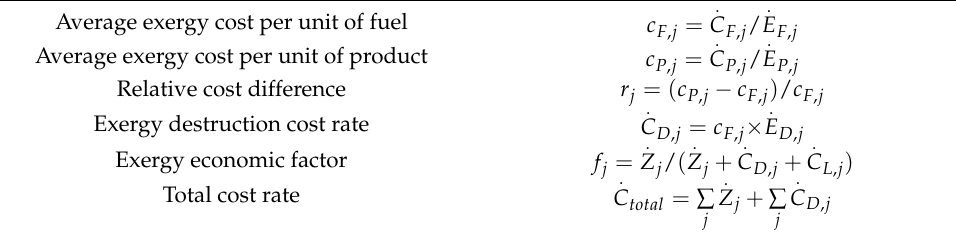
Table A4. Exergoeconomic evaluation parameters